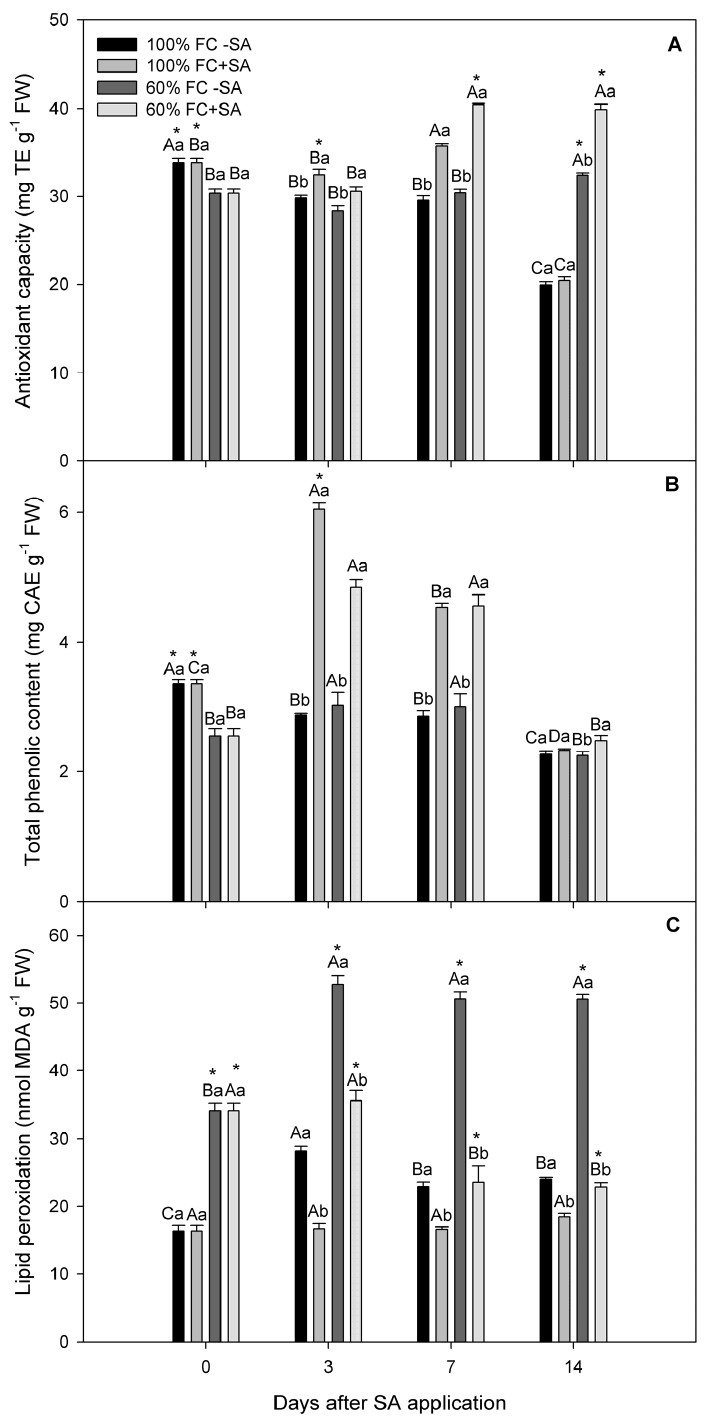
Figure 4. Non-enzymatic antioxidant system and oxidative stress in A. chilensis plants grown 100% and 60% FC and two SA doses (0 and 0.5 mM) at different times. ( A ) Antioxidant capacity, ( B ) total phenolic content, and ( C ) lipid peroxidation. The bars are means ± SE ( n = 3). Different uppercase letters indicate significant differences among times post SA application for the same SA and irrigation treatment according to Tukey’s test ( p ≤ 0.05). Different lowercase letters indicate significant differ- ences between SA treatment for the same irrigation treatment and time post SA application according to Tukey’s test ( p ≤ 0.05). According to Tukey’s test, asterisks indicate significant differences between irrigation treatments of the experiment for the same SA treatment and time post SA application ( p ≤